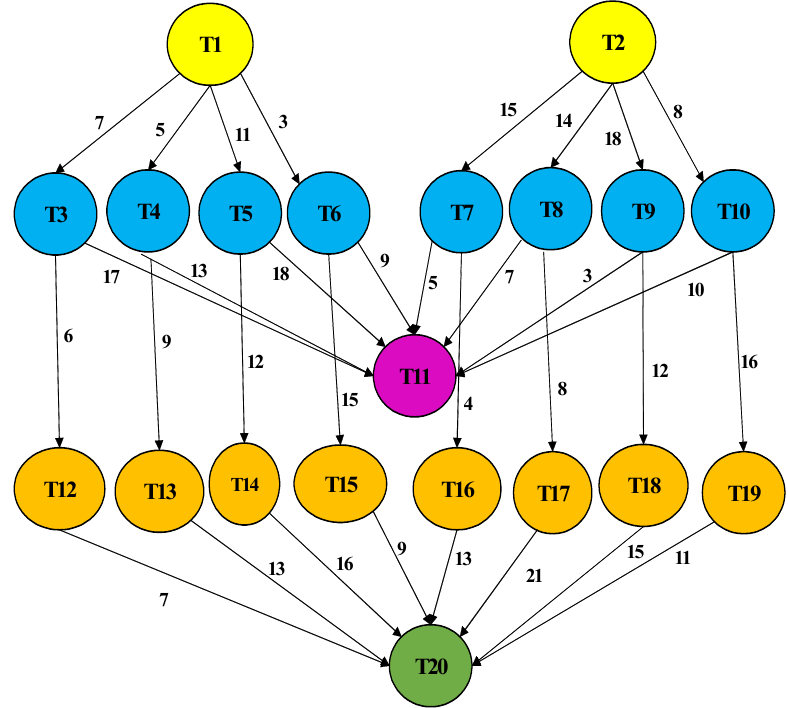
Figure 7. MONWS Workflow application. Table 3. Data Transfer Time (DTT) between the